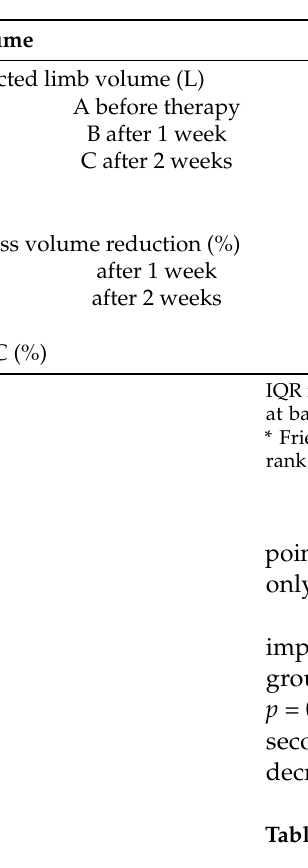
Table 2. Changes in volume within the groups.